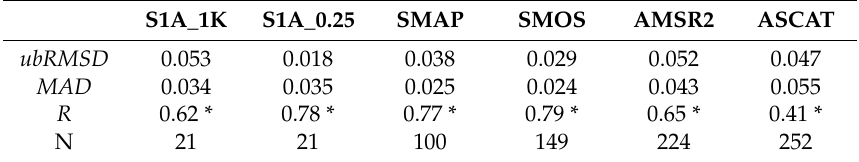
Figure 3. The total daily precipitation and temporal trends of the soil moisture measurements. Table 2. The statistical metrics of the microwave soil moisture products vs. the in situ measurements.